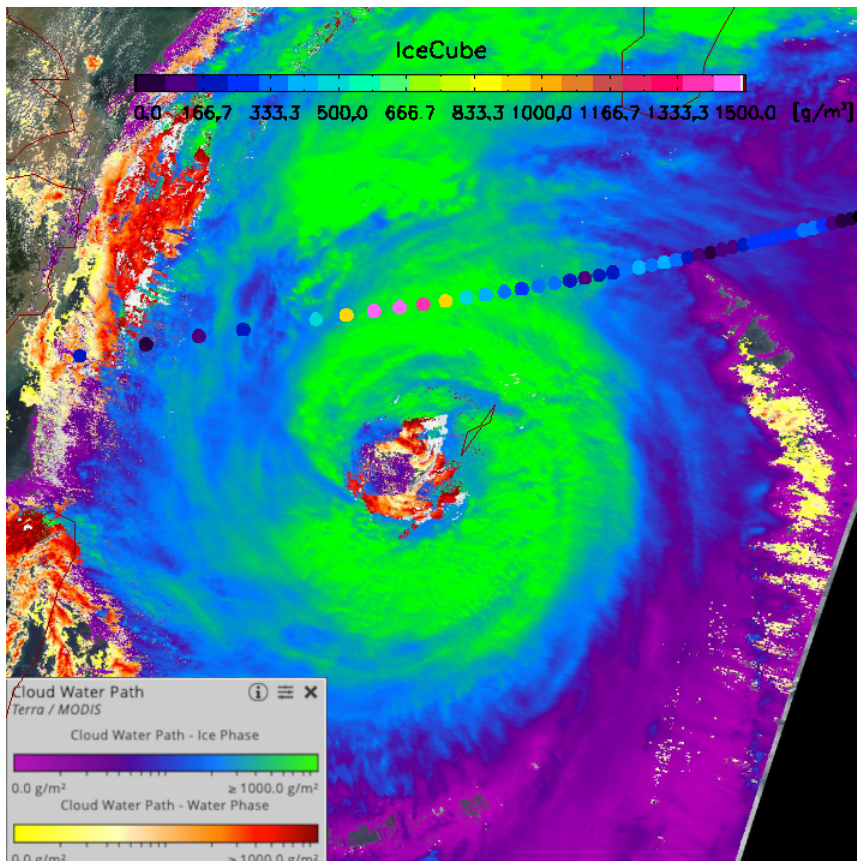
Figure 12. IWP retrievals of Typhoon Trami on 29 September 2018 from an overpass of IceCube (color bar on the top) and Terra–MODIS (color bar on the bottom left corner). Their time difference is about 1.5h. MODIS retrieval image is from https://worldview.earthdata.nasa.gov (last access: 11 November 2021). We acknowledge the use of imagery from the NASA Worldview application (https://worldview.earthdata. nasa.gov, last access: 11 November 2021), part of the NASA Earth Observing System Data and Information System